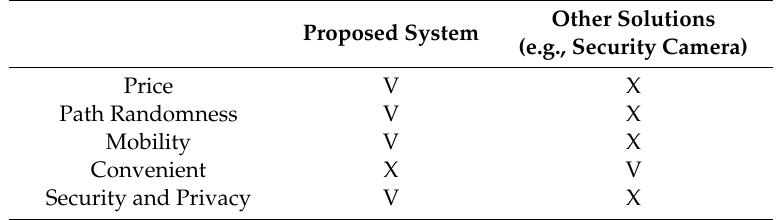
Table 2. The comparison between the proposed system and other